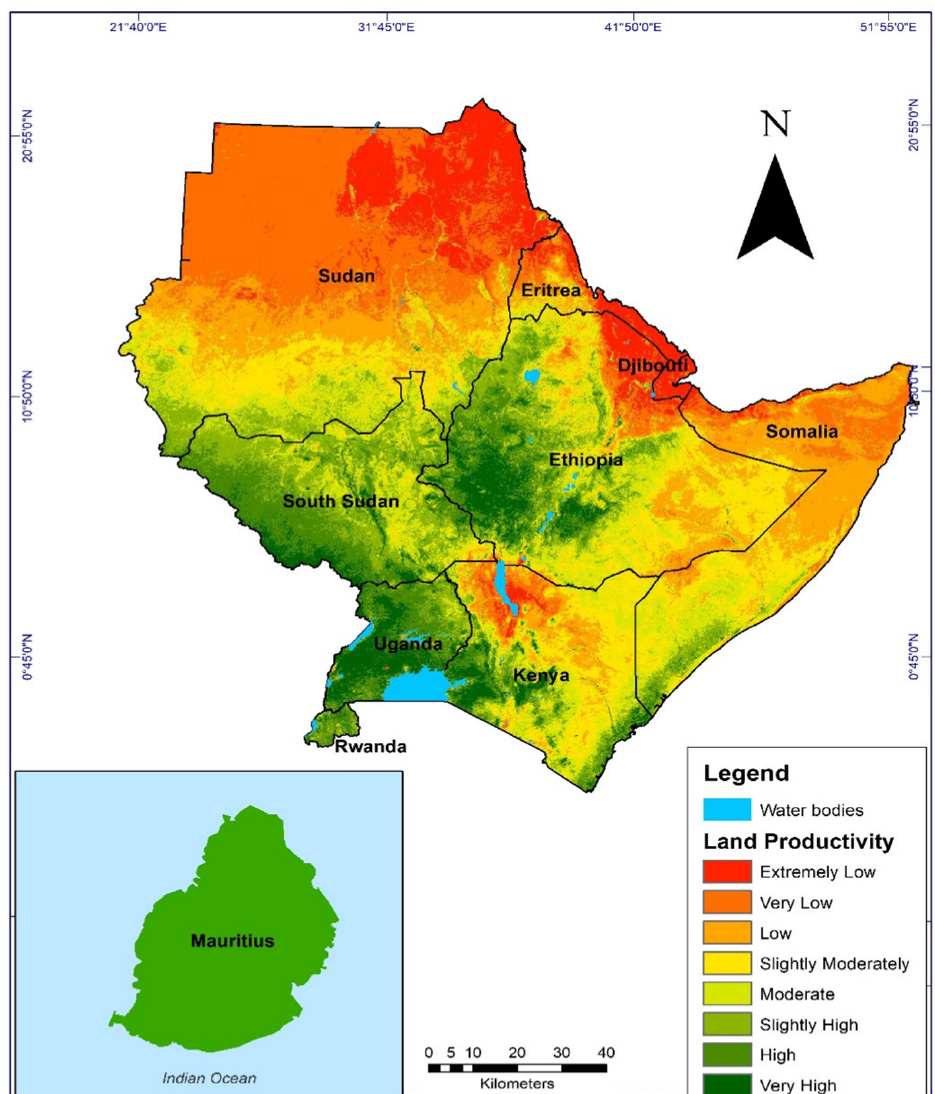
Figure 4. State of land productivity. Table 16. Country specific status of land productivity for the studied countries as per 2019.